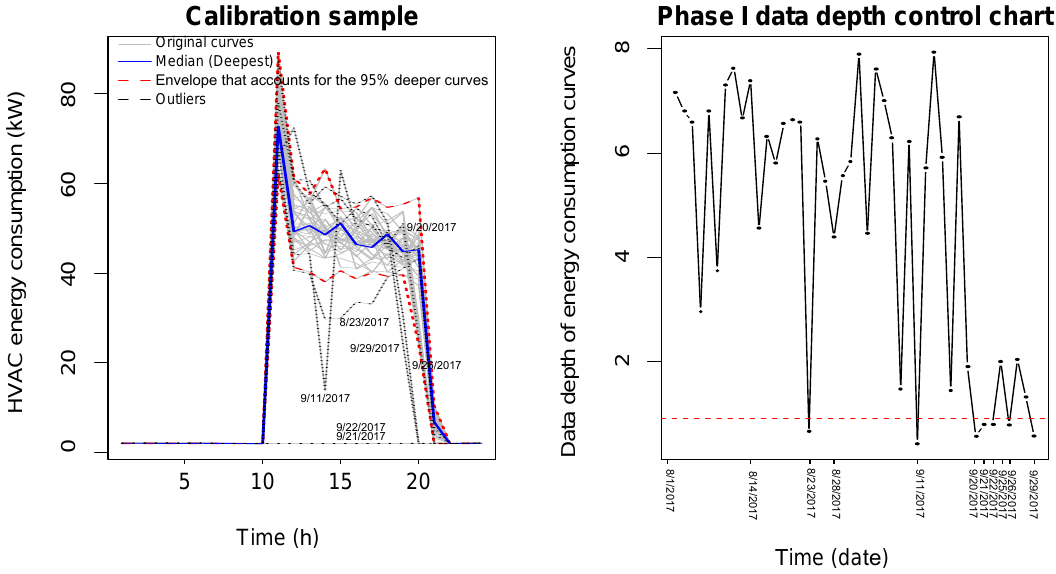
Figure 4. Left panel: Curves of daily energy consumption in HVAC facilities of the Panama City’s store. The figure identifies curves detected as anomalies as well as functional position measurements. Right panel: Control chart corresponds to Phase I; they facilitate the detection of anomalous curves, thus eliminating the assignable causes of variation. The depths of each of the daily consumption curves and the natural control limit are